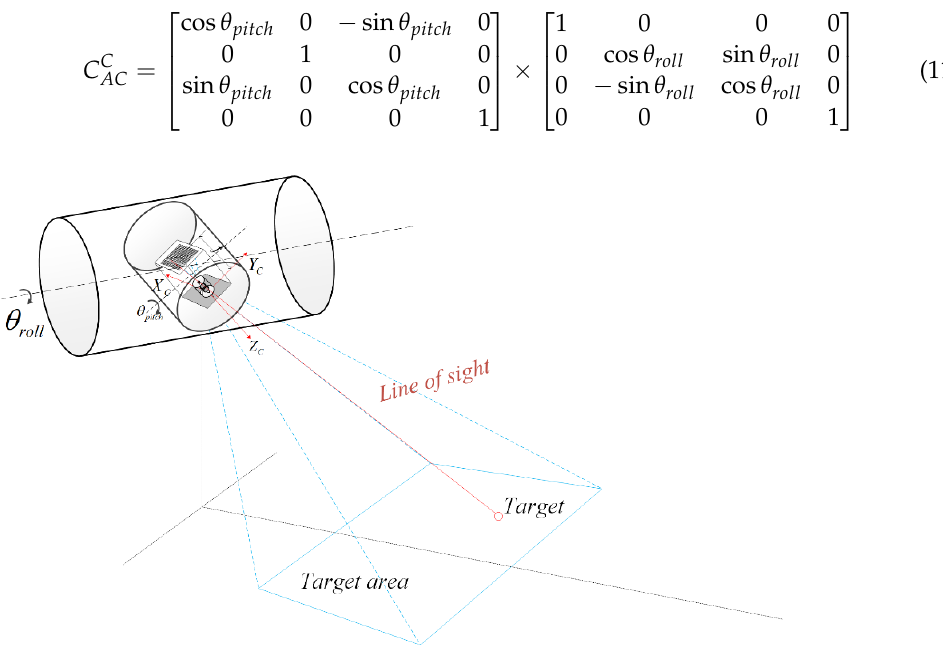
Figure 5. Schematic diagram of camera coordinate system.